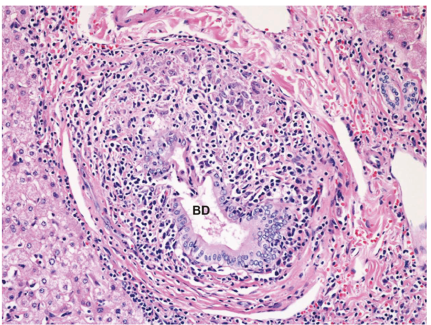
Figure 4: Portal area in the nonlesional liver tissue shows a severely injured bile duct (BD) in fi ltrated by chronic in fl ammatory cells and surrounded by ill-de fi ned granulomatous in fl ammation, typical of the early stage of primary biliary cholangitis (formerly called primary biliary